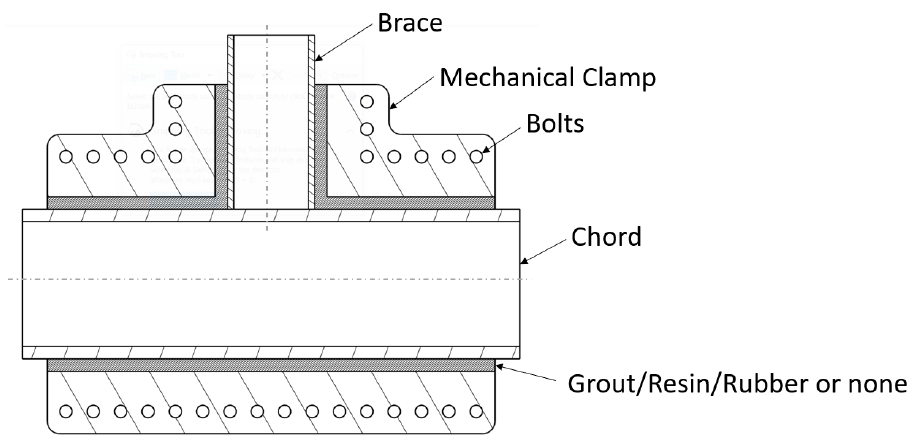
Figure 8. Clamped Figure 8. Clamped T-joint.